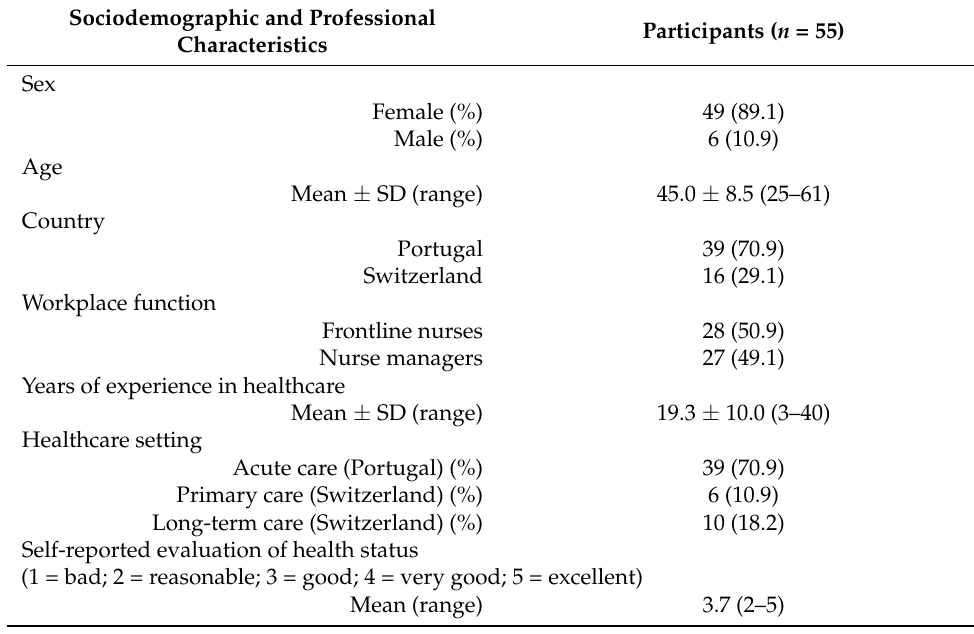
Table 1. Participants’ sociodemographic and professional